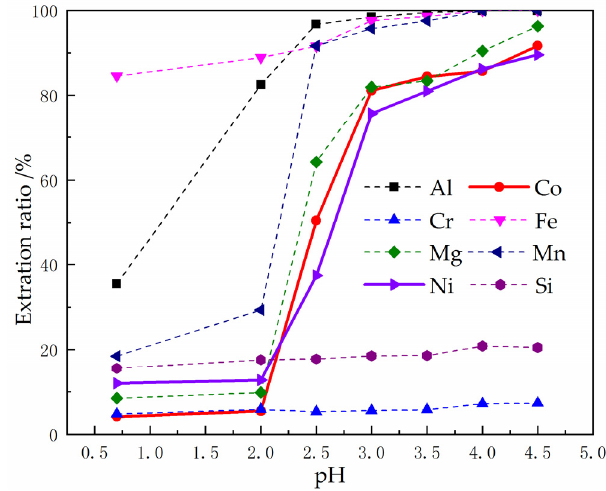
Figure 8. Effect of pH on the extraction of metals with P204. Figure 8. E ff ect of pH on the extraction of metals with P204.